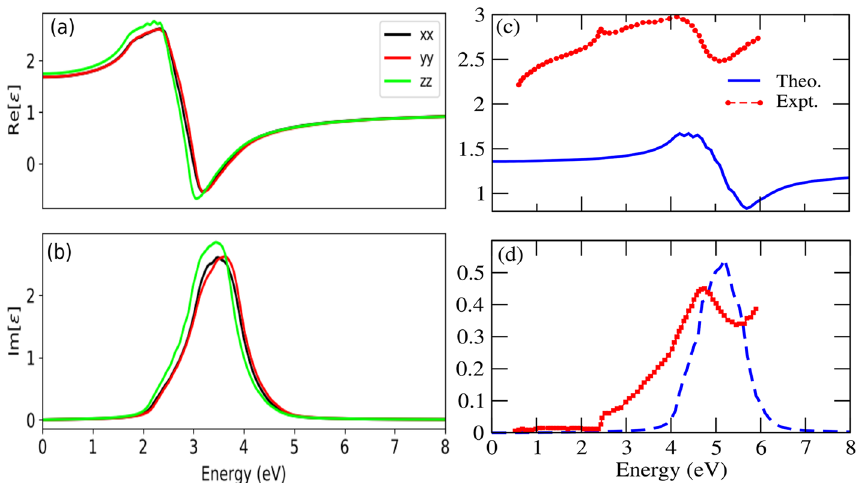
Figure 7. ( a ) Real part of dielectric function ( ε 1 ) of bulk ( b ) Imaginary part of dielectric function ( ε 2 ) of bulk, ( c ) Real part of dielectric function ( ε 1 ) of 001-surface ( d ) Imaginary part of dielectric function ( ε 2 ) of 001-surface, [*our result is compared with the experimental spectra of ε 1 and ε 2 (denoted by red dot) Expt. 76 ].